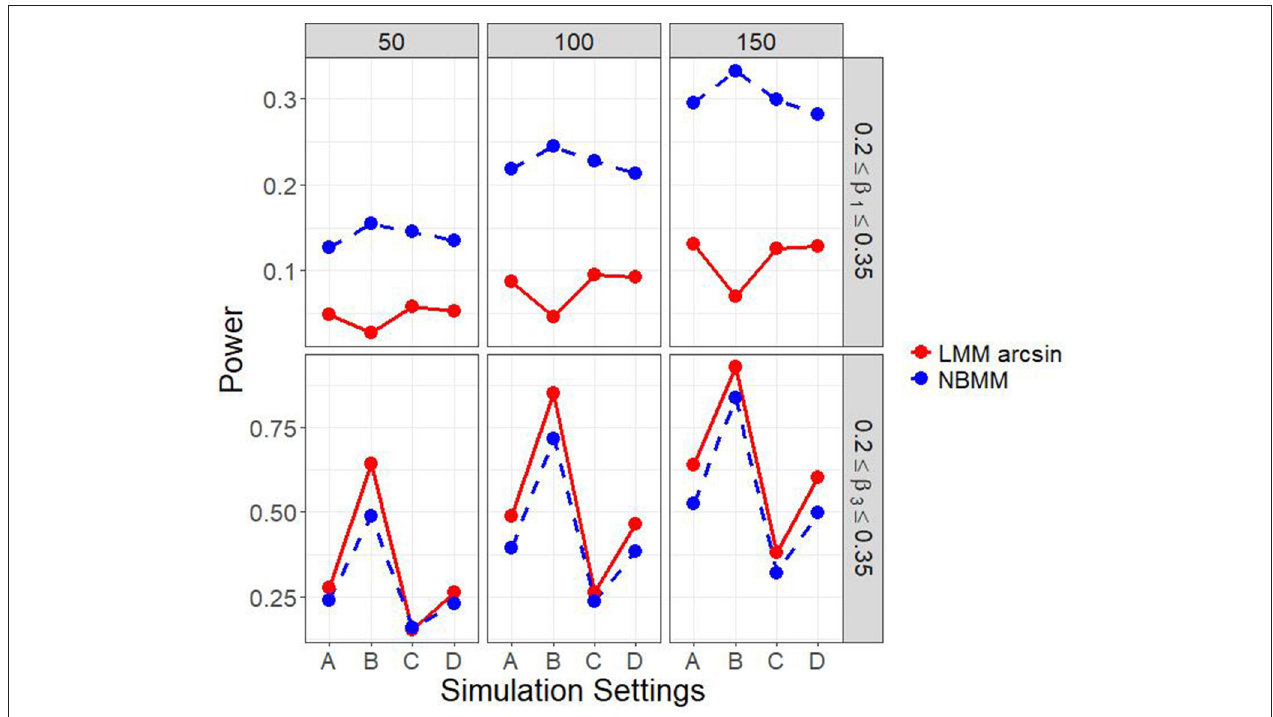
FIGURE 2 | Empirical power of both interaction term and main effect in all four simulation settings.